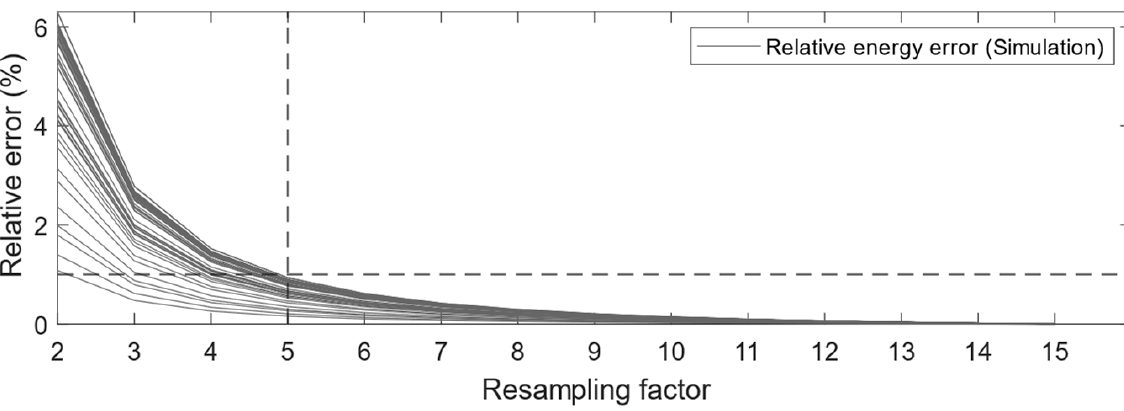
Figure 7. Acceleration data of the left foot on the y -axis (black) and model voltage response (red). The original data were clipped for illustration purposes.